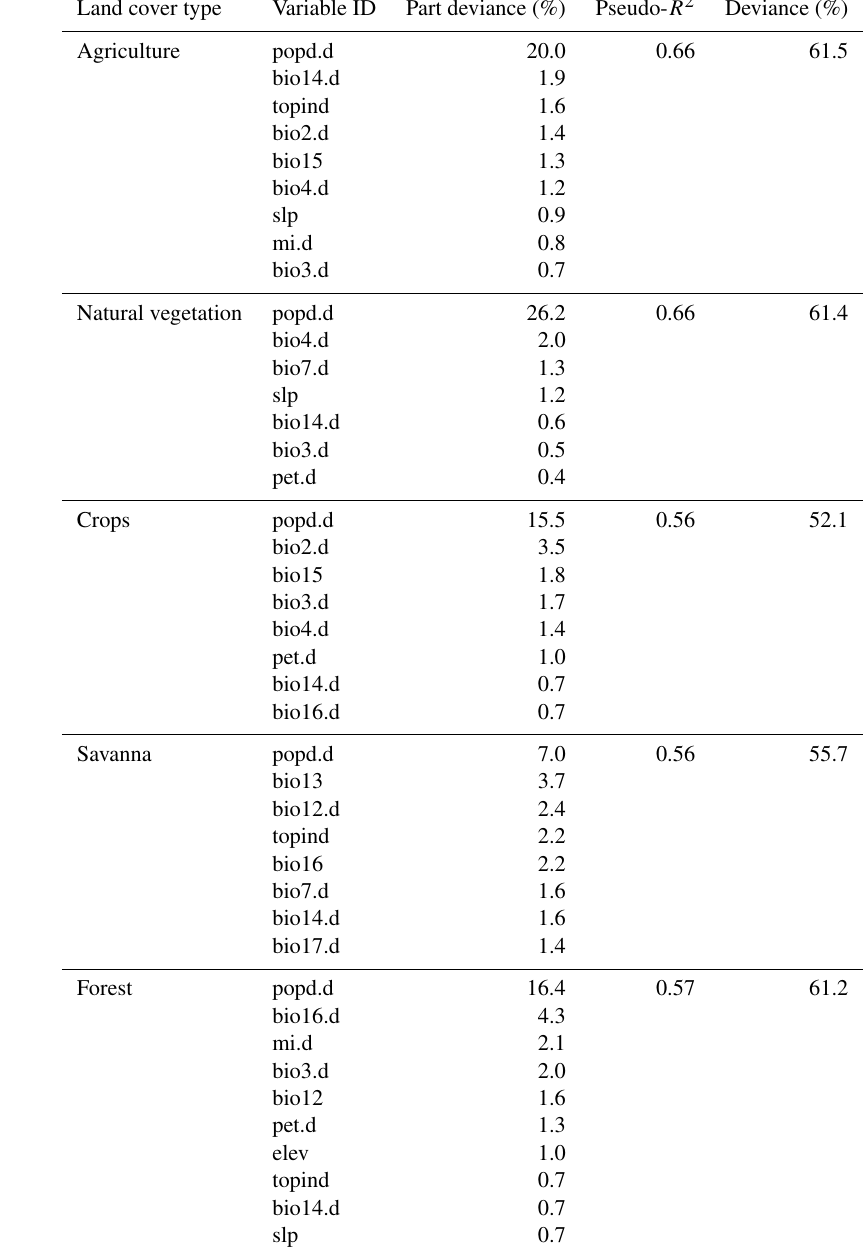
Table 3. Calibration statistics of the generalized additive models used to predict the proportion of land cover ( N = 1576). Predictors are significant at the 99.9% confidence